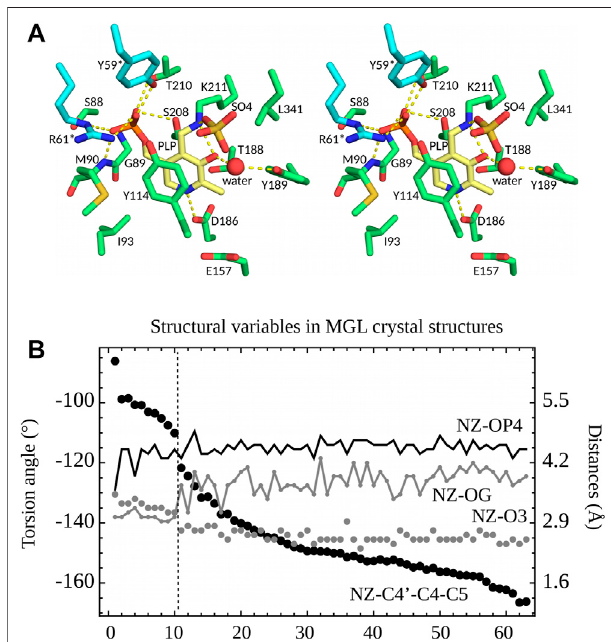
FIGURE 4 | (A) 3D stereo view of the ppMGL active site from the 2O7C crystal structure. Selected side chains are shown, a crystal water, and a sulfate ion present in the PDB structure. Selected interactions are highlighted by yellow dashed lines. The PLP pyridine ring is yellow. (B) Selected structural variables seen in PDB structures of MGL. Structures are ordered according to the dihedral angle C5-C4-C4 ′ -NZ (black dots). A vertical dashed line separates structures (on the left) where the PLP NZ atom has the B orientation and ones (on the right) with the A